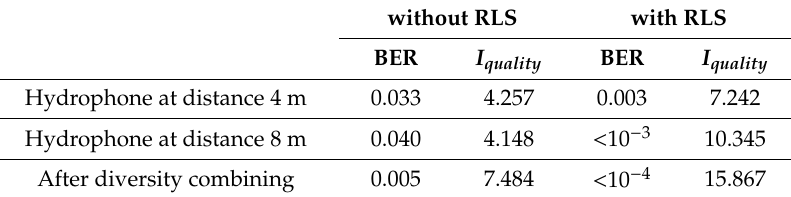
Table 1. Results for data transmission at 4 m and 8 m distances between the hydrophones and the transmitter.